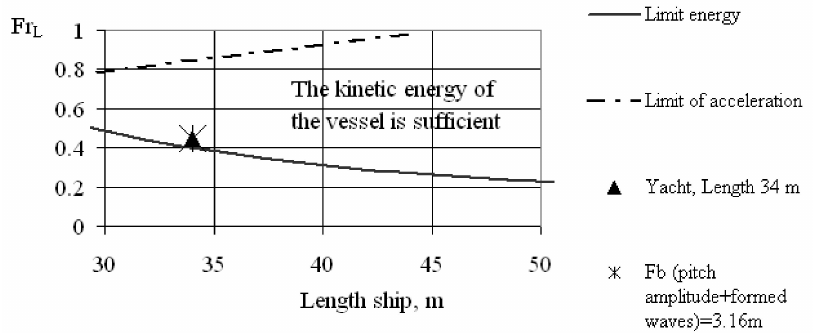
Figure 5. A comparison of the energies of the yacht (length 34 m) and the energy of a wave with a height h 3% = 4 m ( h 1/3 = 3 m).